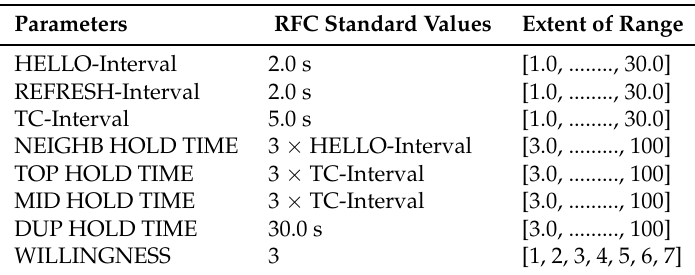
Table 1. OLSR RFC-3626